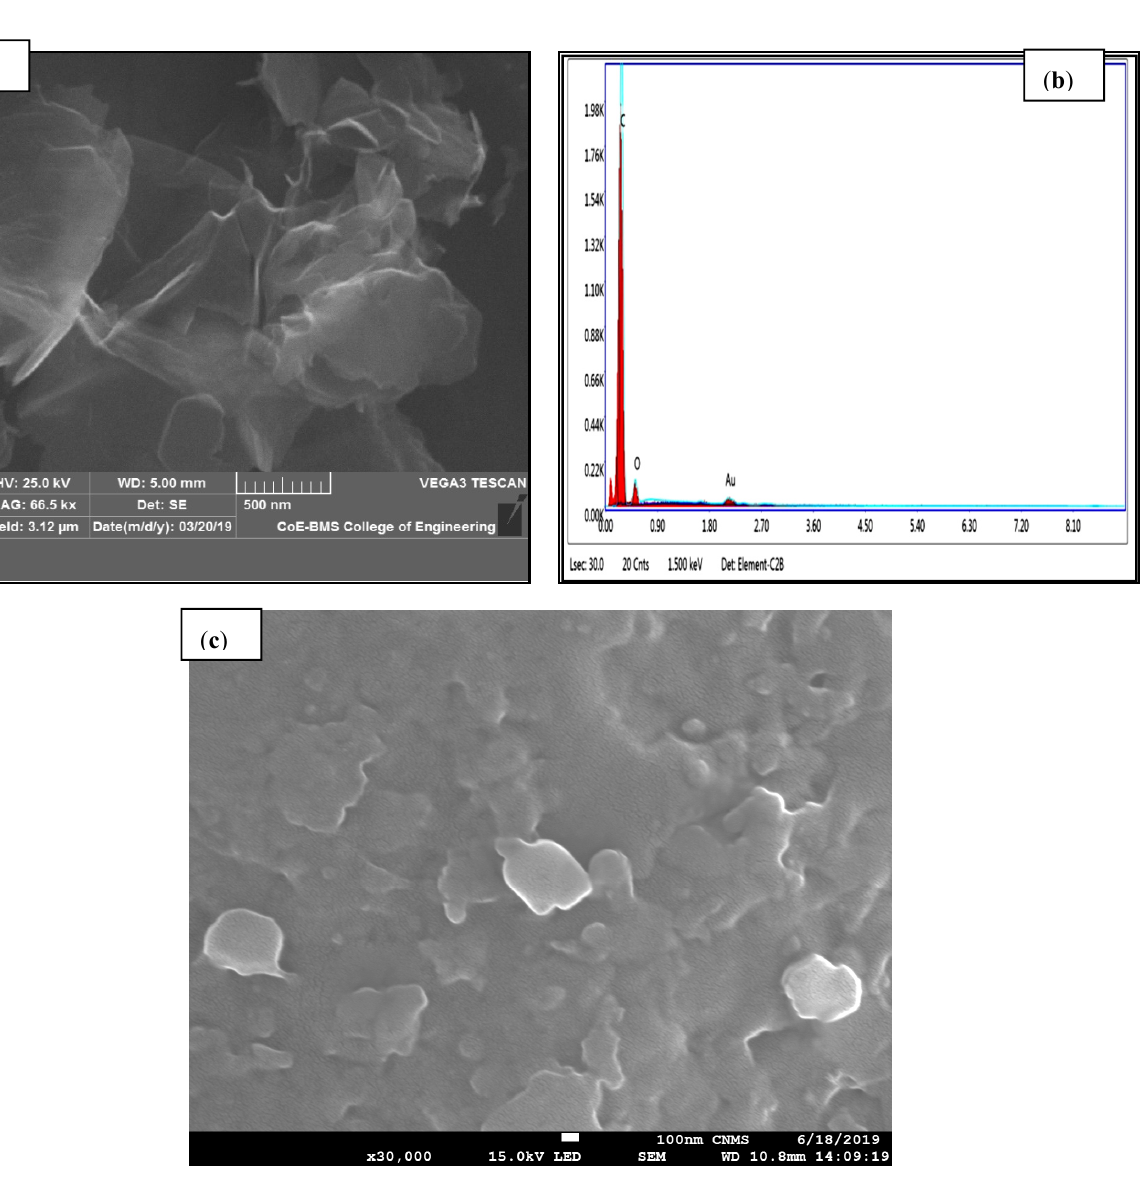
Figure 10. ( a ) SEM of graphene-reinforced PC-ABS. ( b ) EDAX of graphene. ( c ) Graphene dispersion in